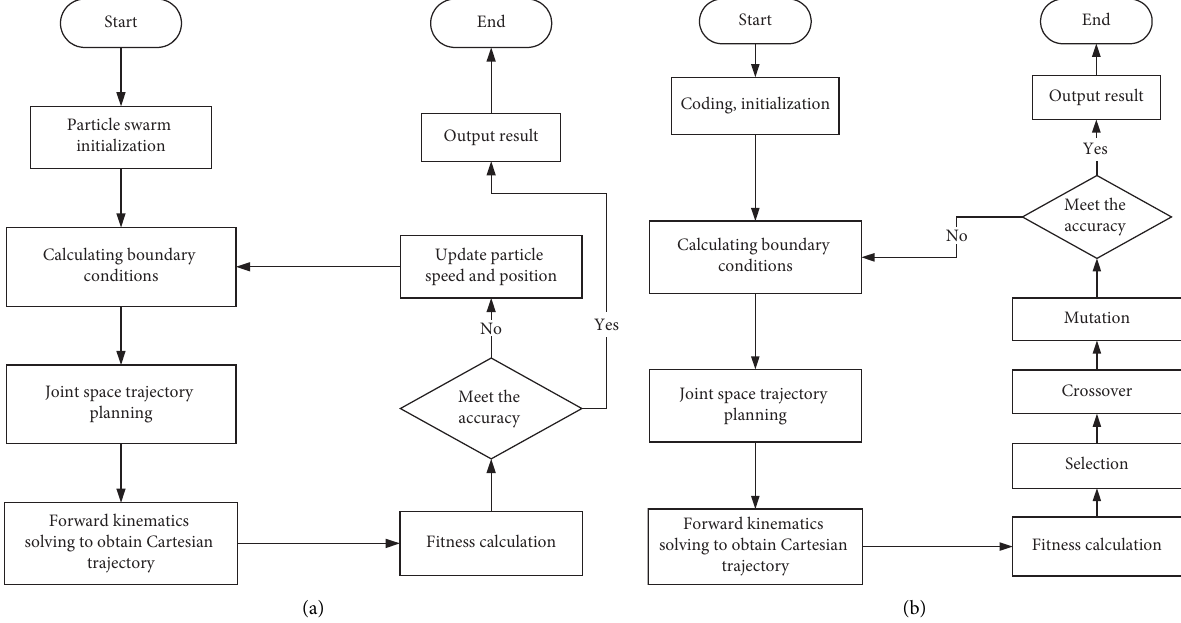
Figure 12: Intelligent optimization algorithms flowchart for point distributions. (a) PSO flowchart. (b) GA